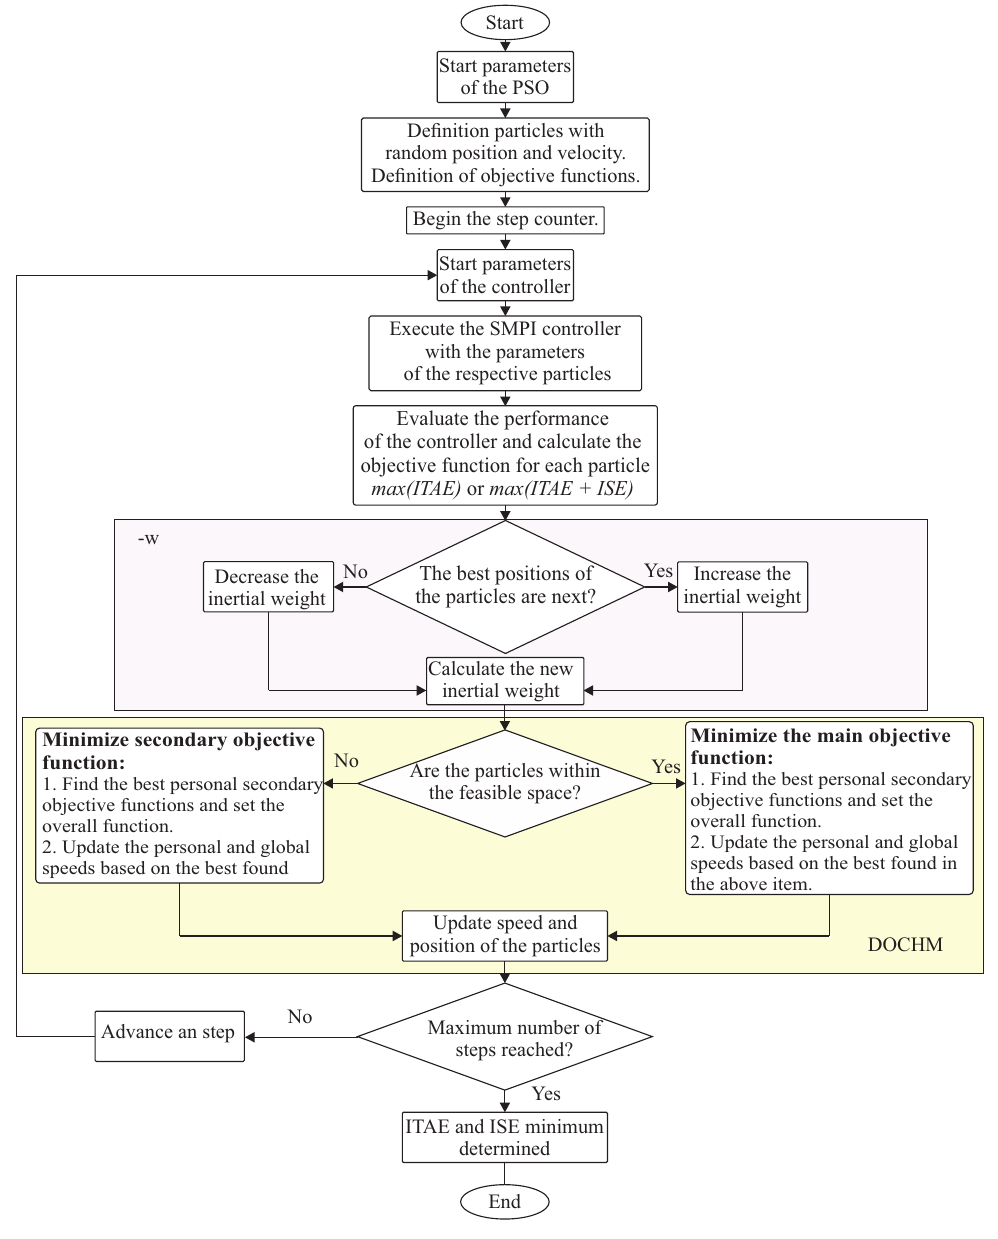
Figure 3. Flowchart of the Particle Swarm Optimization (PSO) algorithm